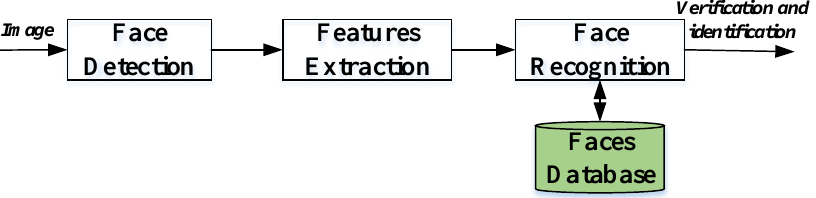
Figure 1. Face recognition structure [3,23].